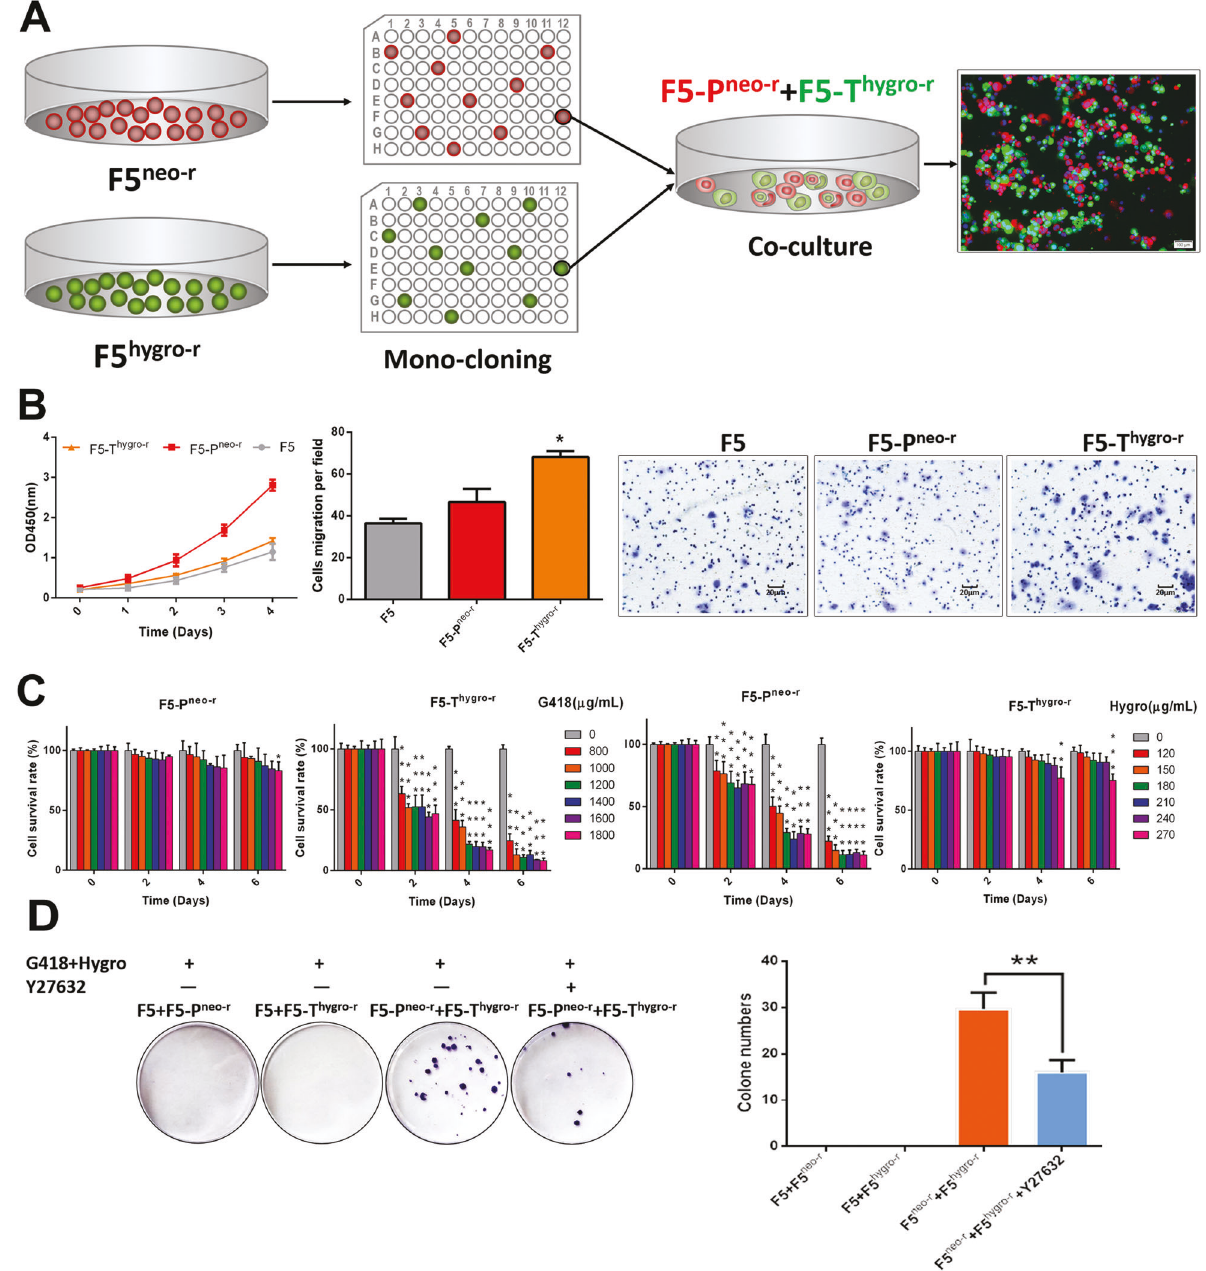
Fig. 1 Producing dual-antibiotics-resistant clones by coculture process. A Schematic diagram of isolating monoclones from F5-P neo-r and F5-T hygro-r by limited dilution. B The proliferation and migration of F5, F5-P neo-r and F5-T hygro-r cells as determined by CCK-8 and transwell assays, respectively. Left panel: growth curve; middle and right panels: quanti fi cation and representative images of cell migration. Data are presented as the mean ± SD. Error bars denote the SD of triplicates. * P < 0.05. C Cell viability of F5-P neo-r and F5-T hygro-r cells in different concentration of G418 or hygromycin B (hygro B) as indicated. Data are presented as the mean ± SD. Error bars denote the SD of triplicates. *** P < 0.001. D Colony formation upon coculture in the presence of dual-antibiotics. F5 or F5-P neo-r cells and F5-T hygro-r were mixed 1:1 in the suspension for 24 h and then plated onto 6 cm plates for culture in complete medium containing G418 (1 mg/ml) and hygro B (150 μ g/ml) in the presence or absence of Y27632 for 1 month. Colonies were stained with Crystal violet. Data are presented as the mean ± SD. Error bars denote the SD of triplicates. ** P < result indicated that the tumorigenicity of the tumor cells increased observed for 4 weeks for tumor formation. While the body weight of after CICs process, suggesting a positive role of CICs-associated gene the mice tended to decrease (Fig. 5A), the xenograft tumors grew transfer in tumor progression. signi fi cantly faster in the CICs clone groups in comparison with the control groups, as manifested by larger tumor volume (Fig. 5B, C) and heavier tumor weight (Fig. 5D). Histological staining showed To explore the molecular changes underlying the malignant that the positive expression of Ki67 protein in the CICs clone groups phenotypes gained by the CICs clones, the gene expression were signi fi cantly higher than those in control groups (Fig. 5E). This